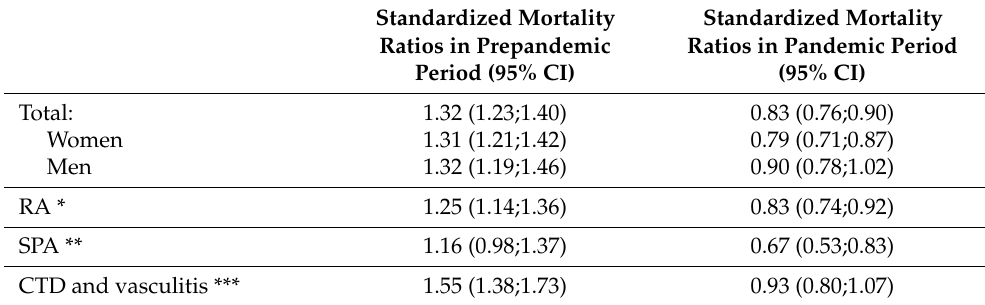
Table 4. Standardized mortality ratios in the RD cohort during the prepandemic and pandemic